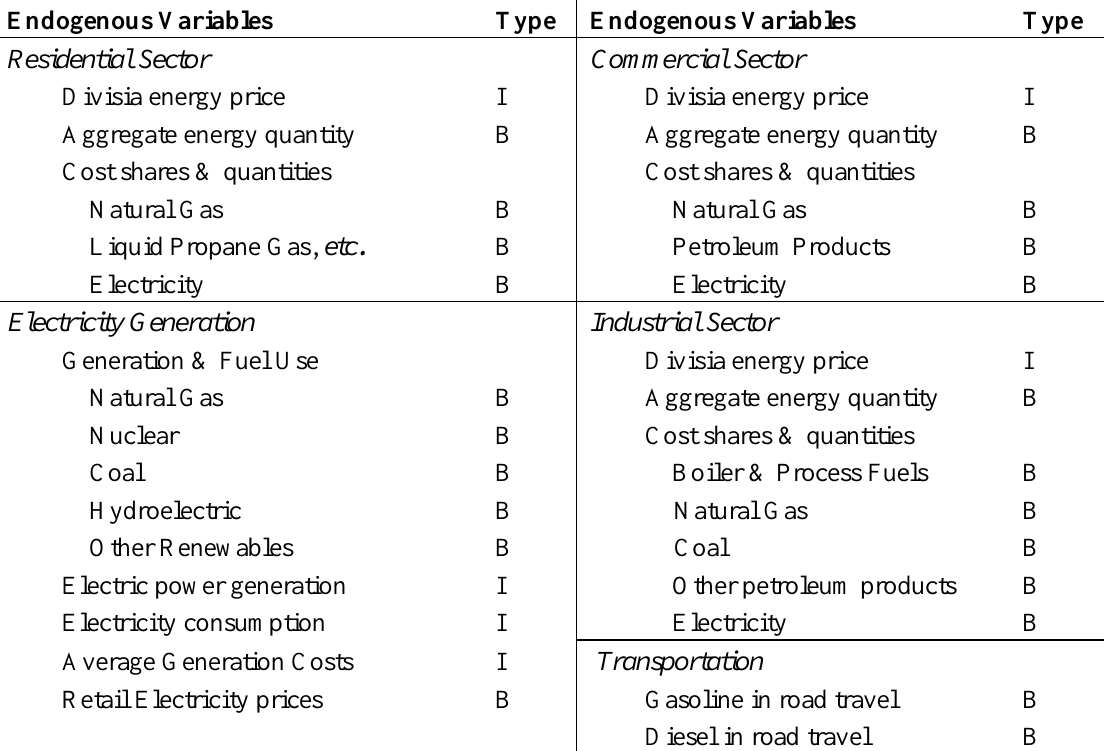
Table 1. Model endogenous variables and